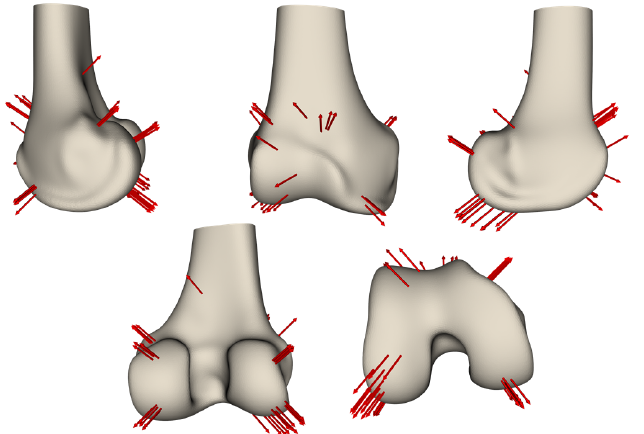
Figure 6. A medial, anterior, lateral, posterior, and distal view of the directions of the β g vectors for the vertices with non-zero